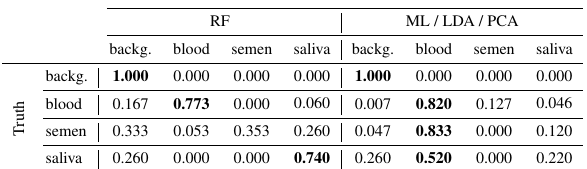
Table 4: Confusion matrix with classwise accuracies for multi- class classification postprocessed by